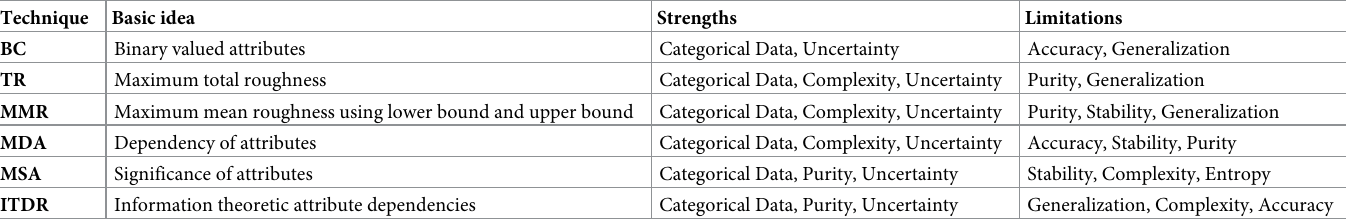
Table 7. Strengths and limitations of existing Rough categorical clustering